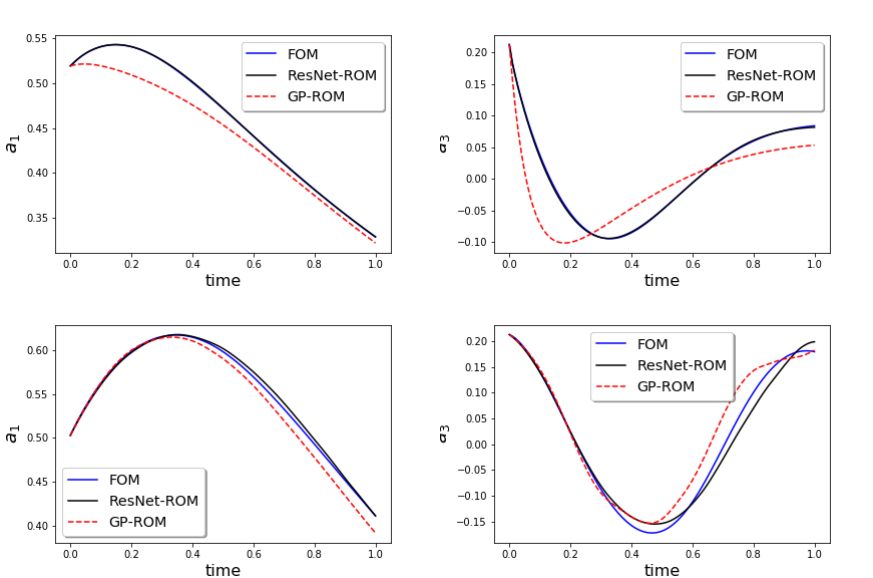
Figure 6. Predictive regime: Time evolution of ROM coefficients a 1 and a 3 for FOM, GP-ROM, and ResNet-ROM. Results for Re = 30 ( top ) and Re = 1200 ( bottom ). ResNet-ROM yields the most accurate